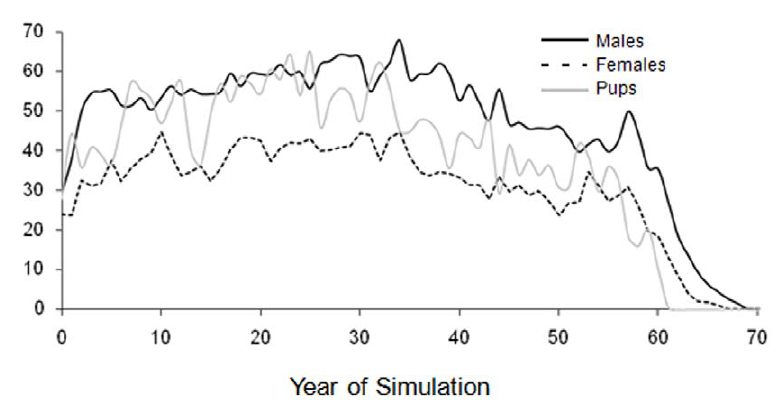
Figure 3. Population composition with avoidance. Average number of adult male, adult female and juvenile wild dogs in simulated populations maintaining an inbreeding threshold of